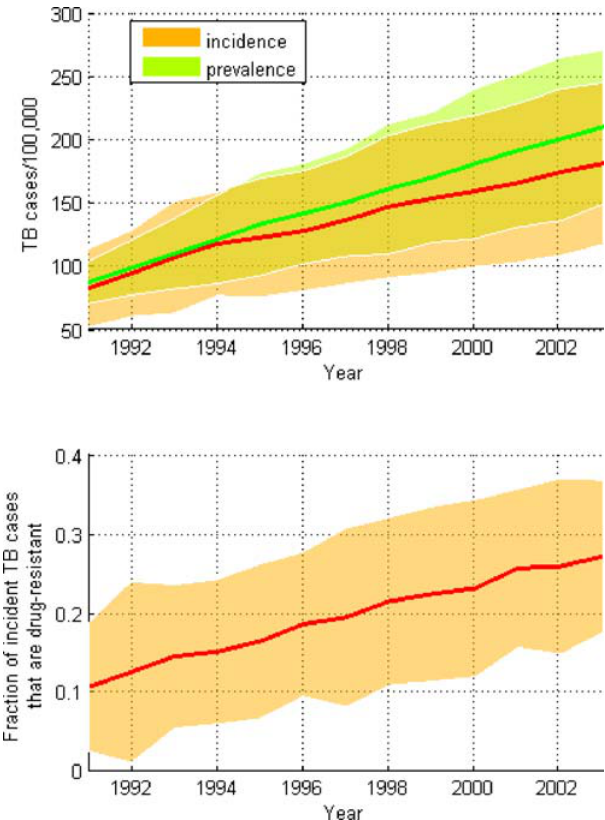
Figure 3. Simulated epidemics. Means and approximate 95% CIs for simulated DR TB epidemics reflecting the incidence (red line, orange shading), prevalence (green line, lime shading), and proportion of disease which is DR (lower